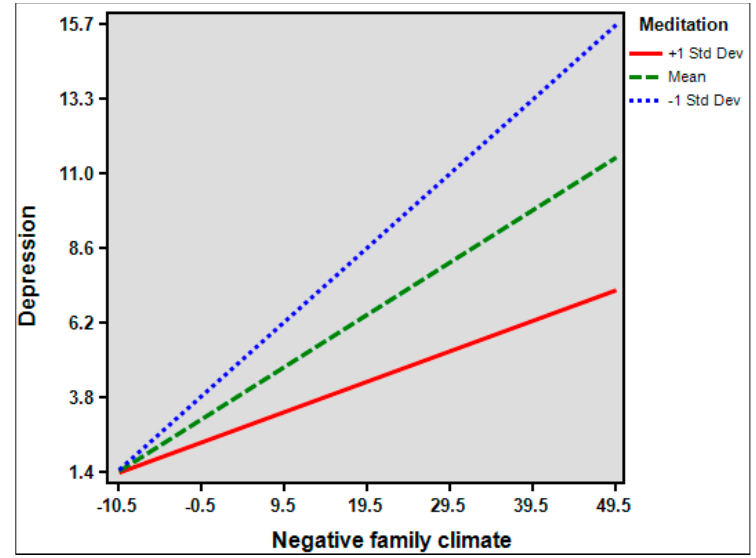
Figure 3. Borderline personality disorder symptoms as a function of the interaction between Negative Family Climate and meditation.